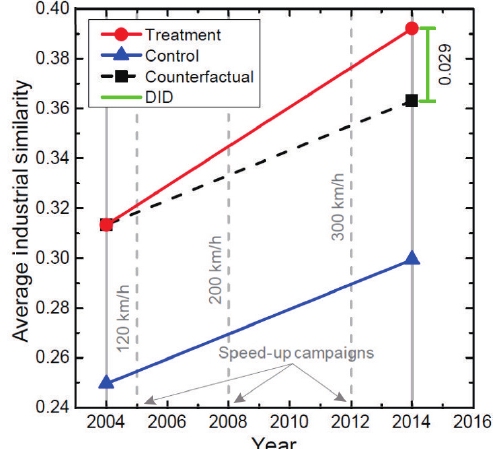
Fig. 4 Facilitating travel between two cities (here by high- speed rail) is effective at spreading specialized commercial capacity (e.g., IT firms or financial firms) from one city to the other [27] . In both cases, mixing communities with different expertise and practice resulted in creation of successful companies that leveraged the skills of different